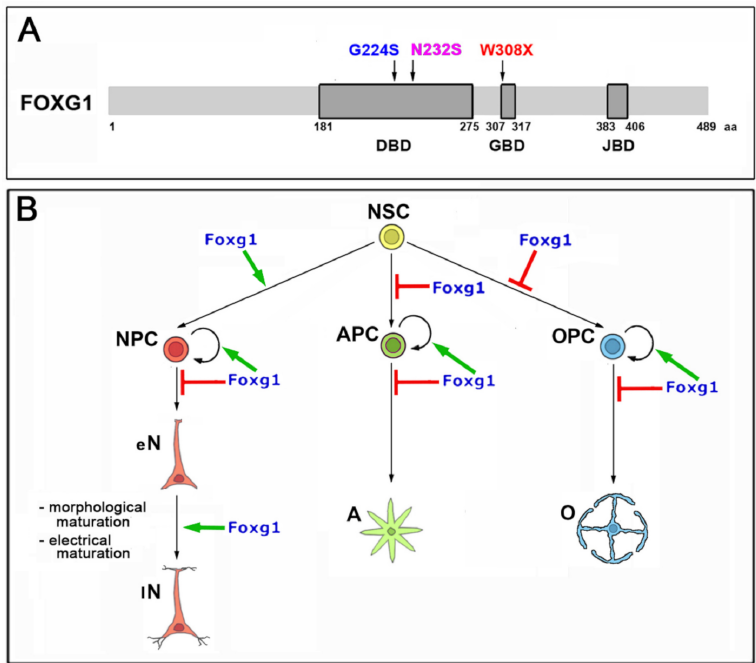
Figure 1. Foxg1: a structural and functional summary. ( A ) Foxg1 protein and selected variants of it. Boxed are the three Foxg1 domains, forkhead DNA binding domain (DBD), Groucho binding domain (GBD), and Jarid1B binding domain (JBD). On the top, the three structural mutations subject of this study. ( B ) Graphical summary of Foxg1 impact on main subroutines of neocortical histogenesis. NSC, neural stem cells; NPC, neuron progenitor cells; eN, early neurons; lN, late neurons; APC, astrocyte progenitor cells; A, astrocytes; OPC, oligodendrocyte progenitor cells; O,